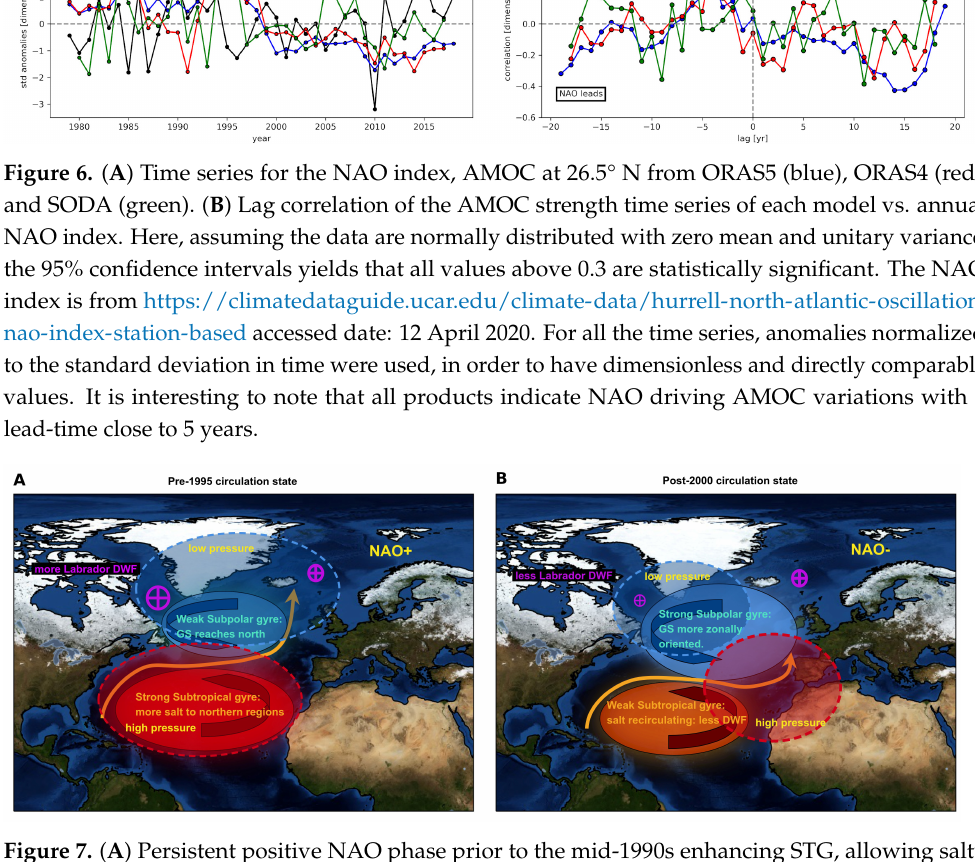
Figure 7. ( A ) Persistent positive NAO phase prior to the mid-1990s enhancing STG, allowing salty water to reach northern latitude—stronger deep convection in the first AMOC period. ( B ) Oceanic response in correspondence to mostly negative or neutral NAO phase, where deep convection is reduced. This simplified sketch should be considered a simplification of the delayed ocean response to a persistent positive NAO phase prior to the mid-1990s and its phase change afterwards, not as an high-fidelity picture encompassing all the timescales at